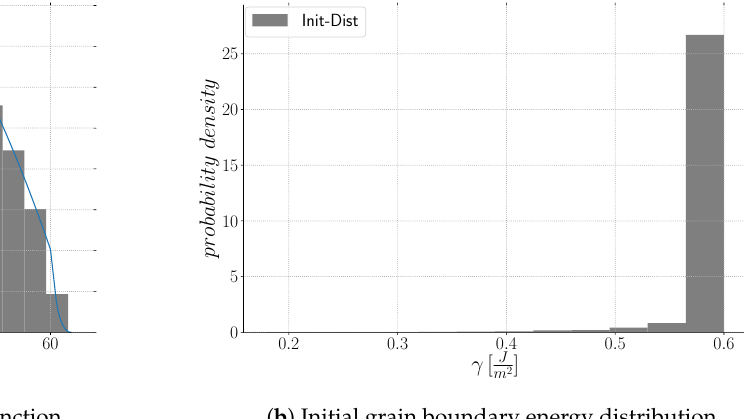
Figure 13. Initial GB